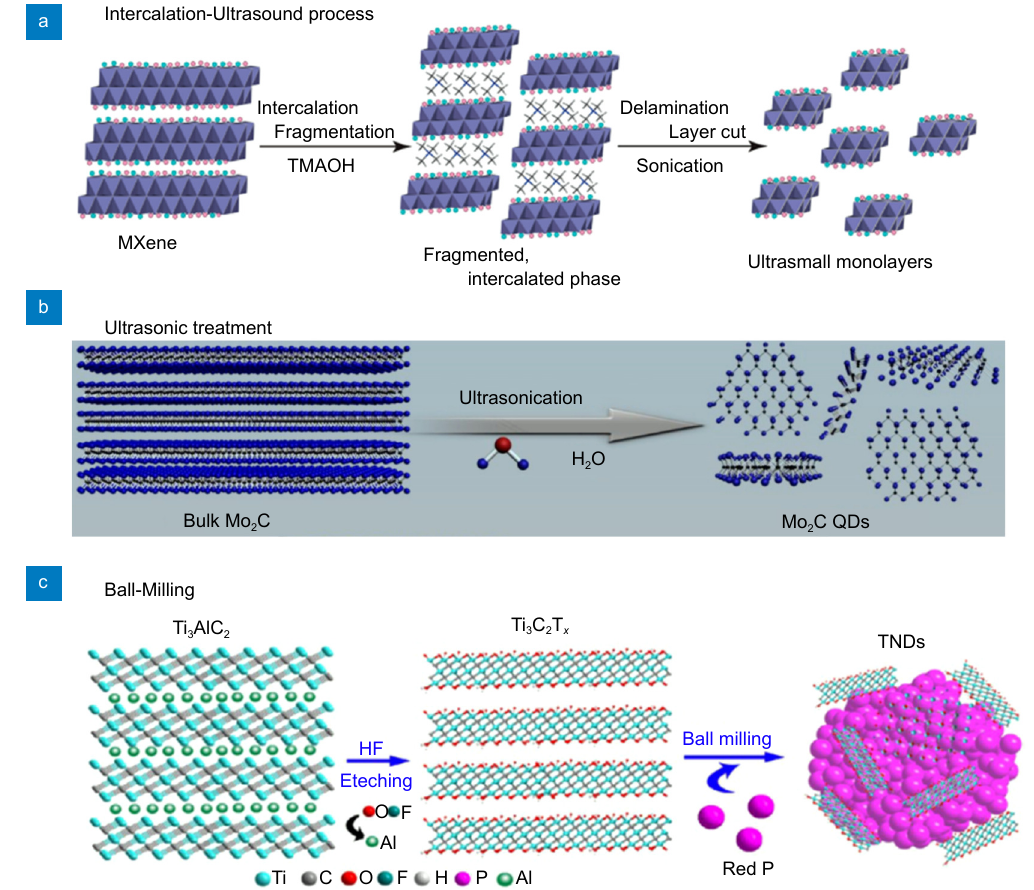
Fig. 4 | Ultrasonic, ball milling, and intercalation synthesis methods. The figures were reproduced from: ( a ) ref. 33 , Copyright 2017, American Chemical Society; ( b ) ref. 80 , Copyright 2018, under a Creative Commons Attribution lisence; ( c ) ref. 81 , Copyright 2018,